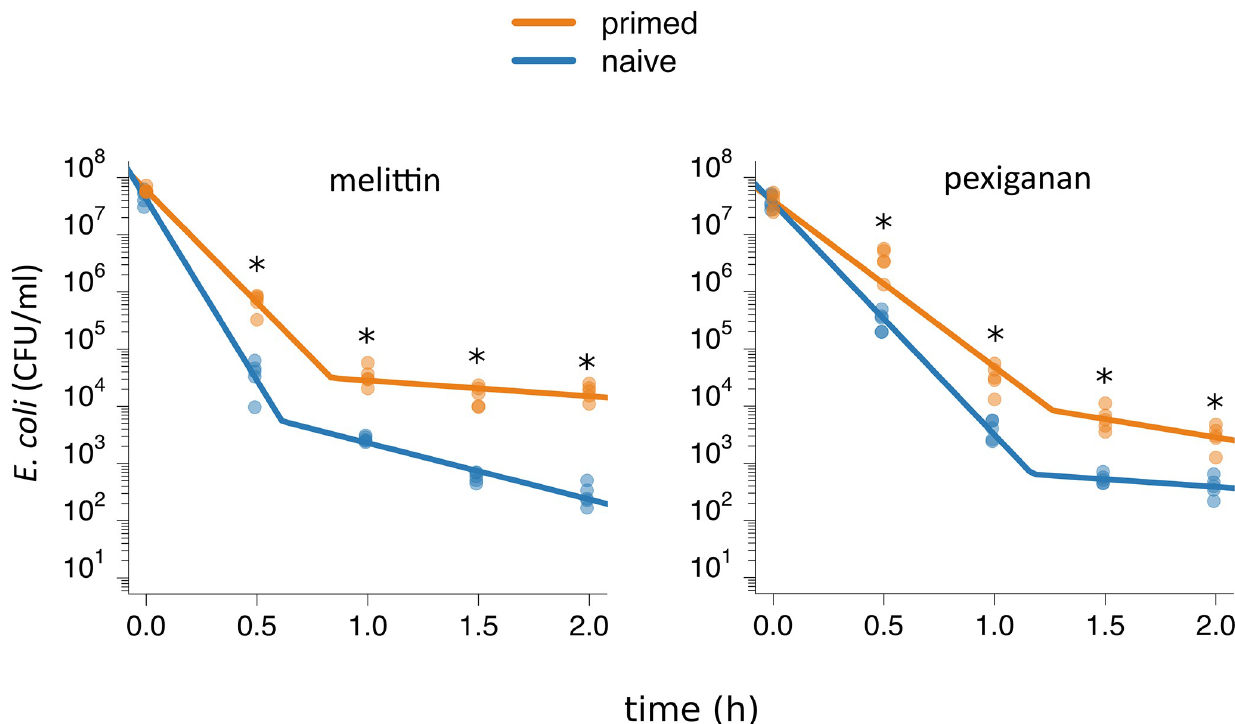
Fig 1. Bacterial tolerance and persistence determine the shape of time-kill curves. Time-kill experiments with E . coli K-12 MG1655: primed (orange) and naive (blue) bacteria were exposed to 10xMIC of (A) melittin and (B) pexiganan. At each time-point, we measured the bacterial population size 5 times. We tested if priming influenced tolerance and persistence with contrasts following an ANOVA. For both antimicrobials, priming significantly increased the slope of the first phase, the measure of tolerance, and the bacterial level in the second phase, the measure of persistence, (significance level: p < 0.05). We corrected for multiple testing with the Bonferroni-method. The line in the plots indicates the best fit of a biphasic function (S2 Table), on which our statistical analysis is based.